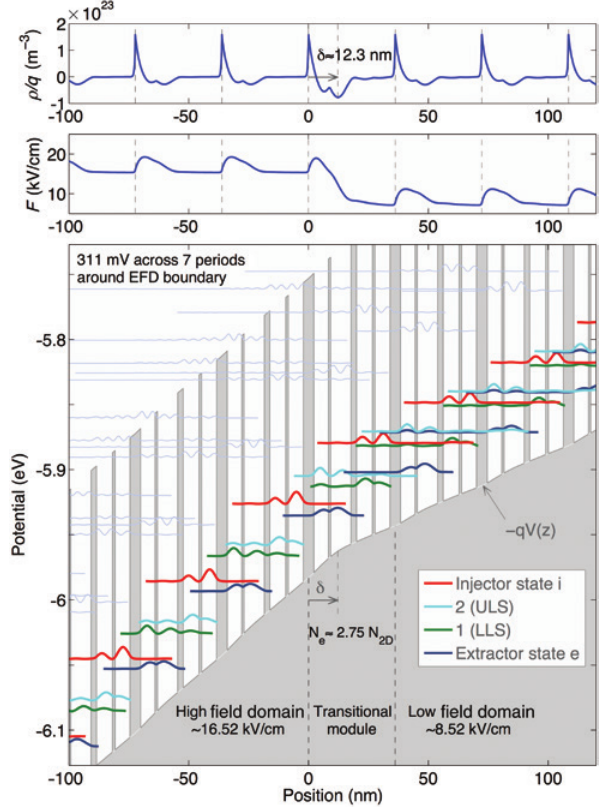
Figure 20: Simulated charge carrier density ( ρ / q , top section); elec- tric field ( F , middle section); and band diagram, electrical potential, and wavefunctions (bottom section) over quantum cascade modules near the EFD boundary. The simulation results confirm that the EFD boundary is ~ 12.3 nm away from the δ -doped injection barrier in the transitional module. The device bias used in the simulation is 12 V.